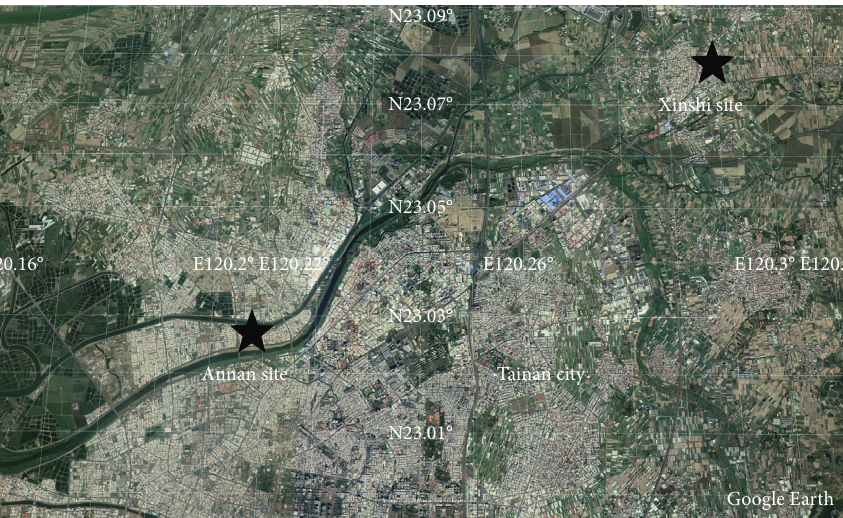
Figure 2: Location of Annan and Xinshi sites in Tainan city (from Google Earth). Table 1: Information of Annan and Xinshi sites in Tainan city.